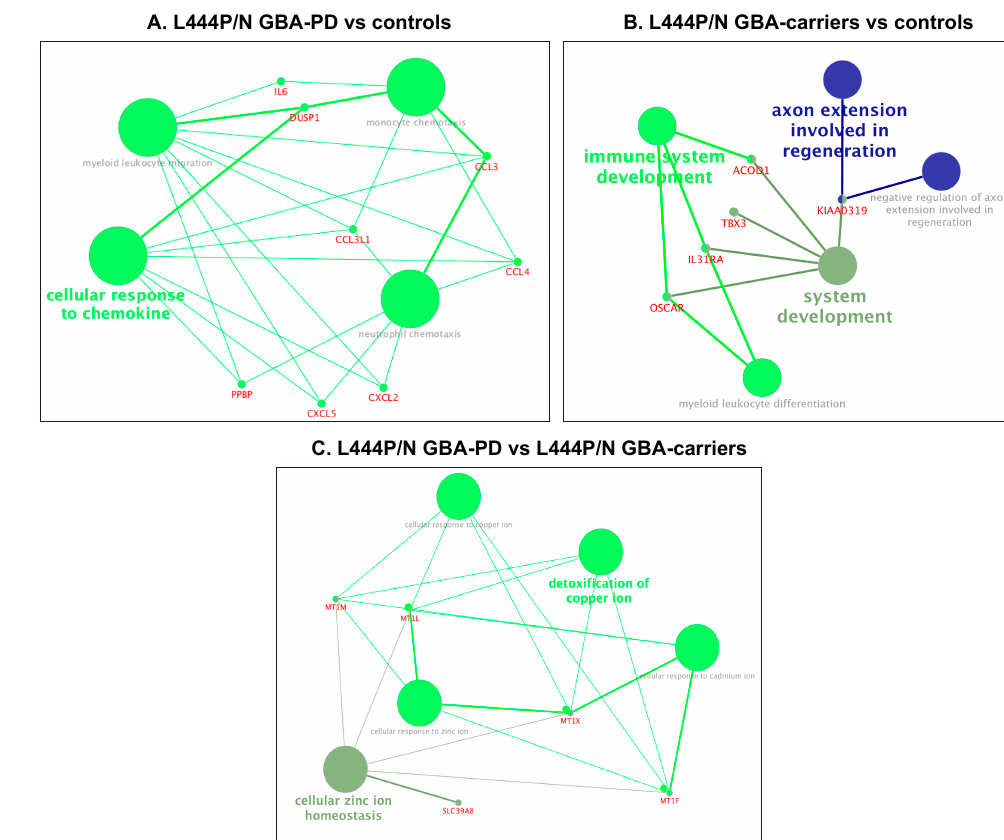
Figure 2. Networks of selected metabolic processes and DEGs in ( A ). L444P/N GBA-PD vs. controls; ( B ). L444P/N GBA carriers vs. controls; ( C ). L444P/N GBA-PD vs. L444P/N GBA carriers (obtained using CluePedia v. 1.5.7 + ClueGo v.2.5.7). (GBA-PD—Parkinson’s disease associated with mutations in the GBA gene; GBA carriers—asymptomatic GBA mutation carriers; DEGs—differentially expressed